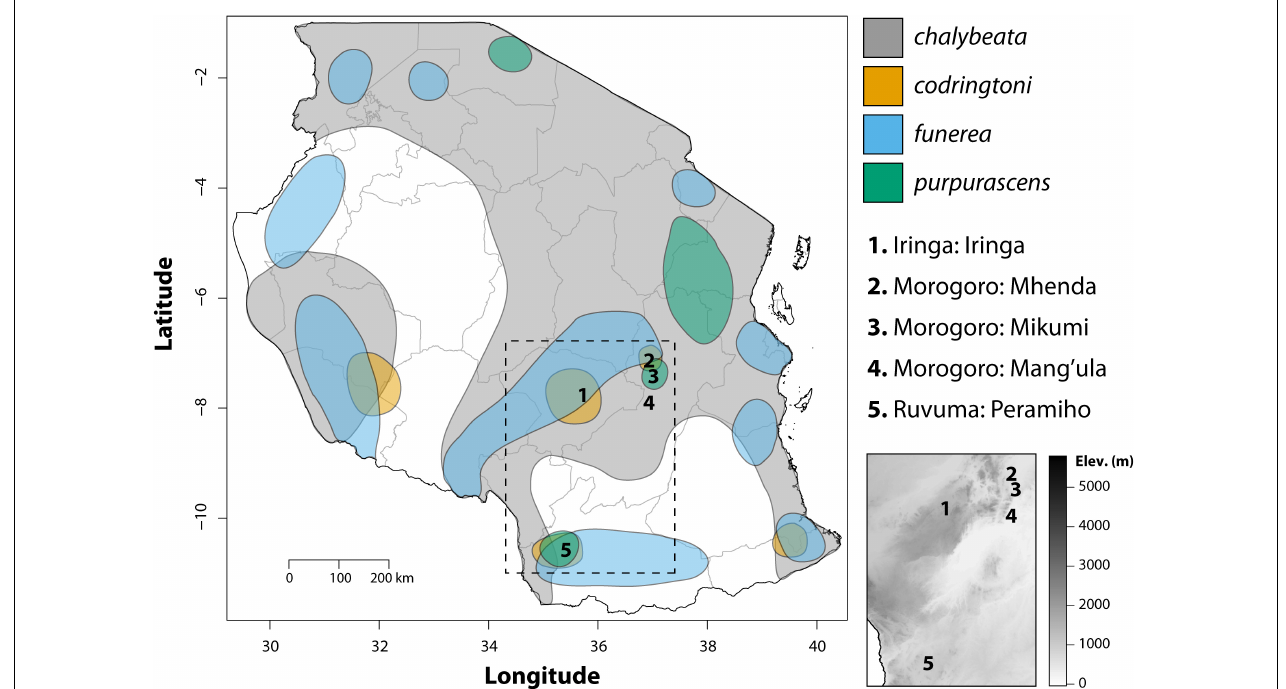
FIGURE 1 | Map showing the geographic distributions of the four indigobird study species in Tanzania adapted from Payne (2010). Numbers indicate sampling localities, interior gray lines show the boundaries of political regions, and the dashed box shows the location of the inset elevation map.